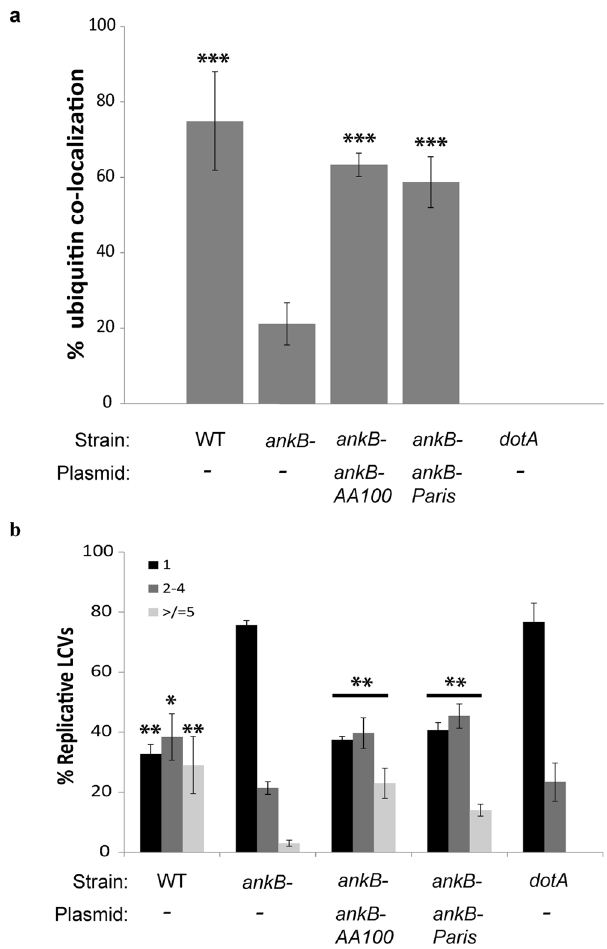
Figure 6. AnkB-Paris complements the ankB mutant of strain AA100/130b. ( a ) Co-localization of polyubiquitinated proteins with the LCV at 2 hours post-infection of hMDMs. Macrophages were infected with either wild type L . pneumophila strain AA100/130b, its isogenic ankB or dotA mutant, or the ankB mutant complemented with ankB-Paris or ankB-AA100 . Numbers indicate the percentage of LCVs ( ± 1 SD) that co-localize with polyubiquitinated proteins. The data are based on analysis of 100 infected cells performed in triplicate and are representative of three independent experiments. ( b ) At 10 hours post-infection hMDMs were fixed, stained with anti-Lpn, and analyzed by confocal microscopy. The number of bacteria per cell was determined and the data are based on analysis of 100 infected cells (mean ± 1 SD) performed in triplicate and are representative of three independent experiments. * p < 0.05, ** p < 0.01, *** p < 0.001 compared to corresponding value for ankB null